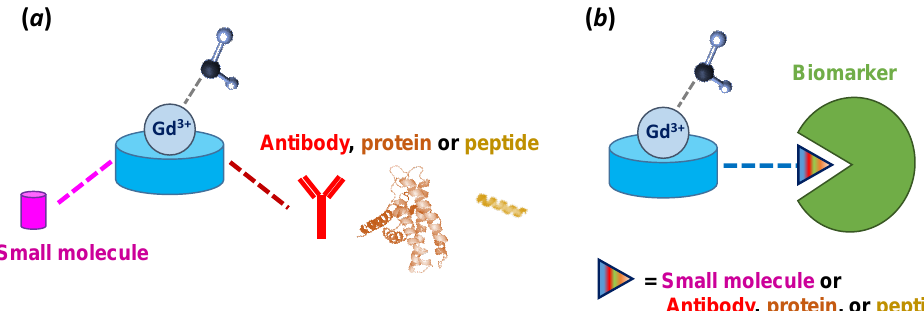
Figure 2. Schematic representation of targeted contrast agents ( a ) and their interaction with the specific biomarker ( b